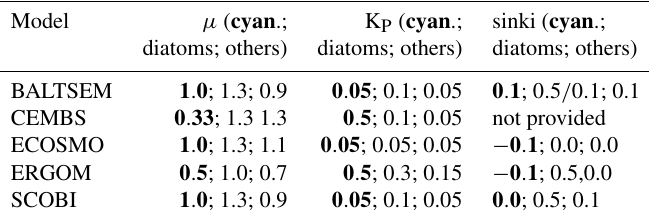
Table 3. Key model parameters impacting cyanobacteria growth and sinking rates of phytoplankton put into relation to the respective param- eters of other functional groups. All models include three functional phytoplankton groups, including cyanobacteria and diatoms. The third functional group, however, is called “flagellates” in ECOSMO, ERGOM, and SCOBI, while BALTSEM refers to the third functional group as “summer species” and CEMBS as “small phytoplankton”. Note that the ERGOM model uses a modified Michaelis–Menten formulation and the half-saturation constants are thus not directly comparable to the other models. For models which include temperature dependence (Fig. 1), the values provided refer to 0 ◦ C (BALTSEM). Note that, as a peculiarity, the BALTSEM models use different sinking rates for diatoms in spring and autumn, and the sinking speed also depends on temperature, environmental conditions, and morphology. Also, the half-saturation constants for the BALTSEM model and the maximum growth rates of the CEMBS model are unit-converted from the original values. The bold text refers to